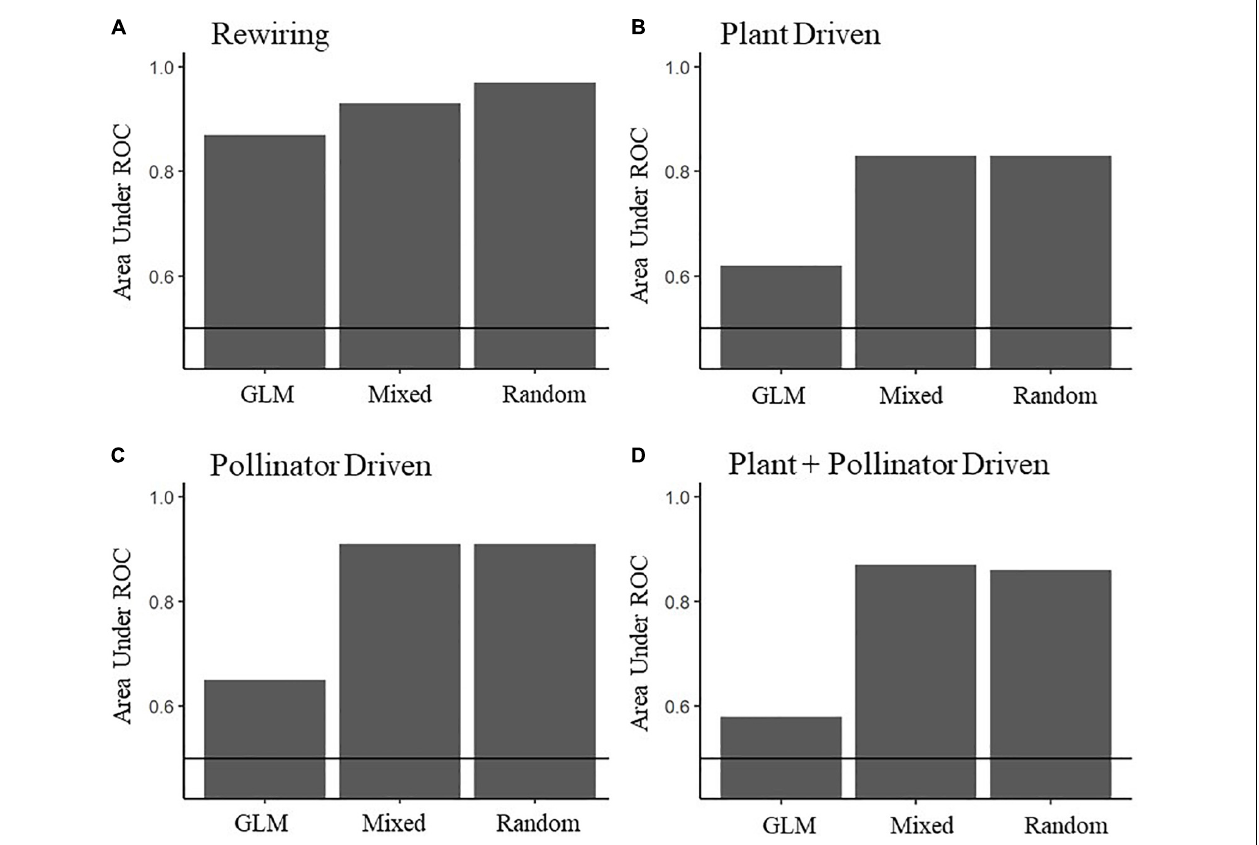
FIGURE 5 | Area under the Receiver Operating Curve (AUC) values for models predicting interaction rewiring (A) , plant driven interaction turnover (B) , pollinator driven interaction turnover (C) , and both plant + pollinator driven interaction turnover (D) . The receiver operating curve is created by plotting the true positive rate (TPR) against the false positive rate (FPR) at various threshold settings. The closer AUC is to one, the better the model performance. GLM refers to a model using landscape, ecological and network variables, Mixed refers to a GLMM with landscape, ecological and network variables as fixed effects and species identity as random effects and Random refers to a GLMM using species identity as random effects. The horizontal line is 0.5 AUC, where the model performs no better than